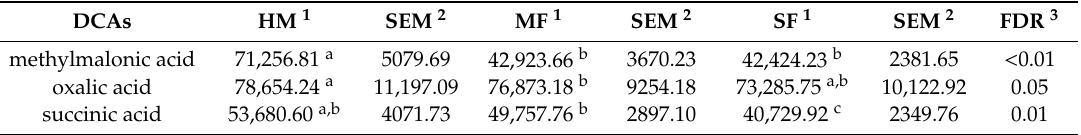
Table 5. Average abundances (quantifier ion (quantion) intensities) of urinary dicarboxylic acids (DCAs) significantly di ff erent when comparing human milk (HM; n = 93), cow’s milk-based formula (MF; n = 80), and soy-formula (SF; n = 76) diet groups of infants at 3 months of